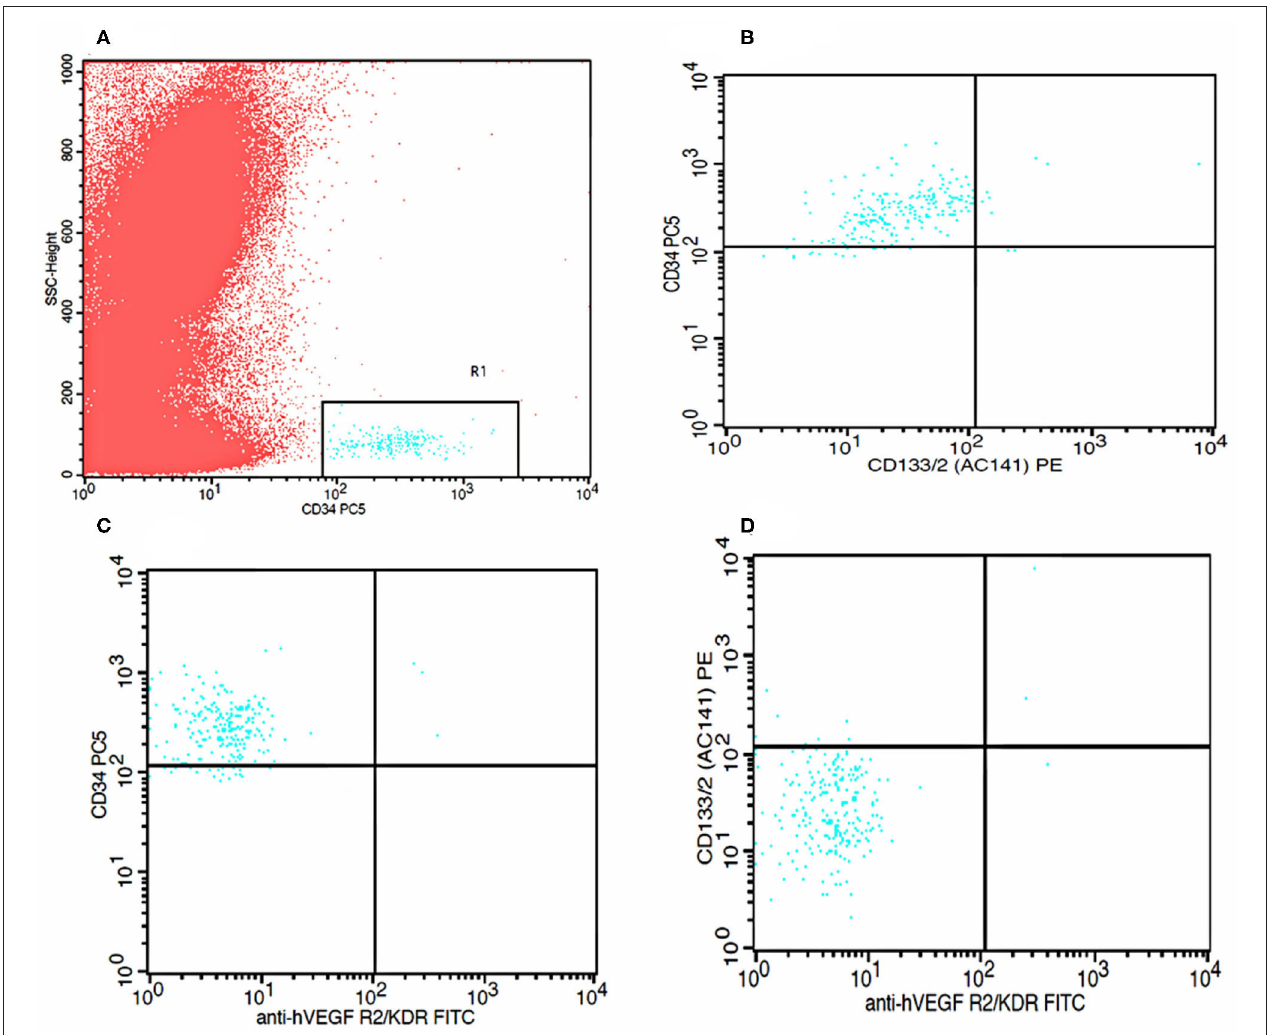
FIGURE 1 | Flow cytometry analysis graphs. (A) Identification of CD34 positive cells. (B) Identification of CD 133 positive cells within CD34 positive cells. (C) Identification of KDR positive cells within CD34 positive cells. (D) Identification of both CD133 positive and KDR positive cells within CD34 positive